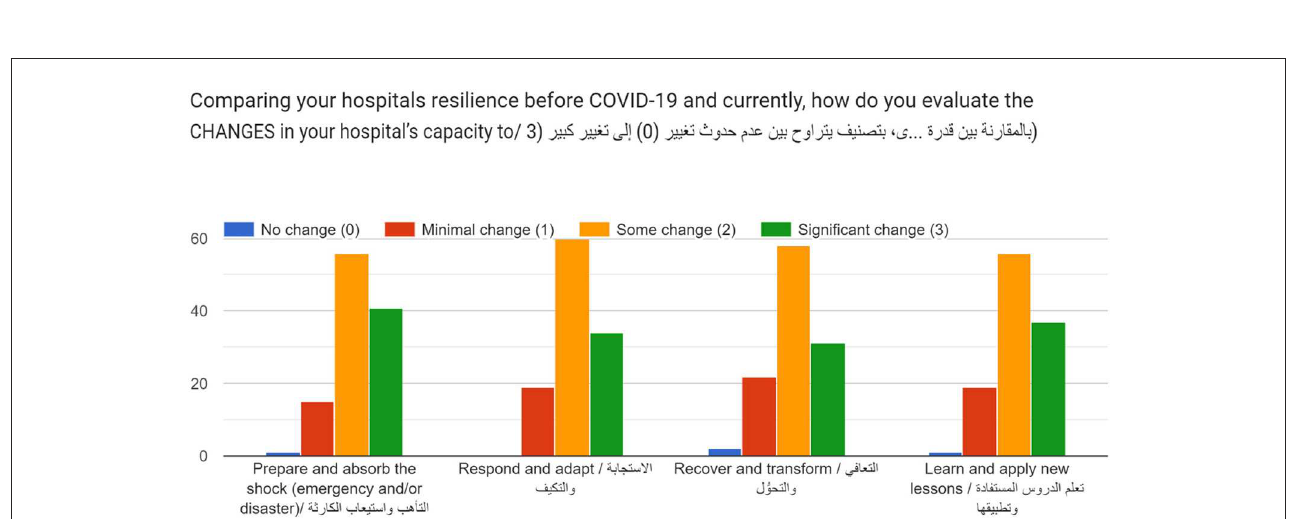
FIGURE8 Evaluation of changes in hospital resilience before COVID-19 and in the current